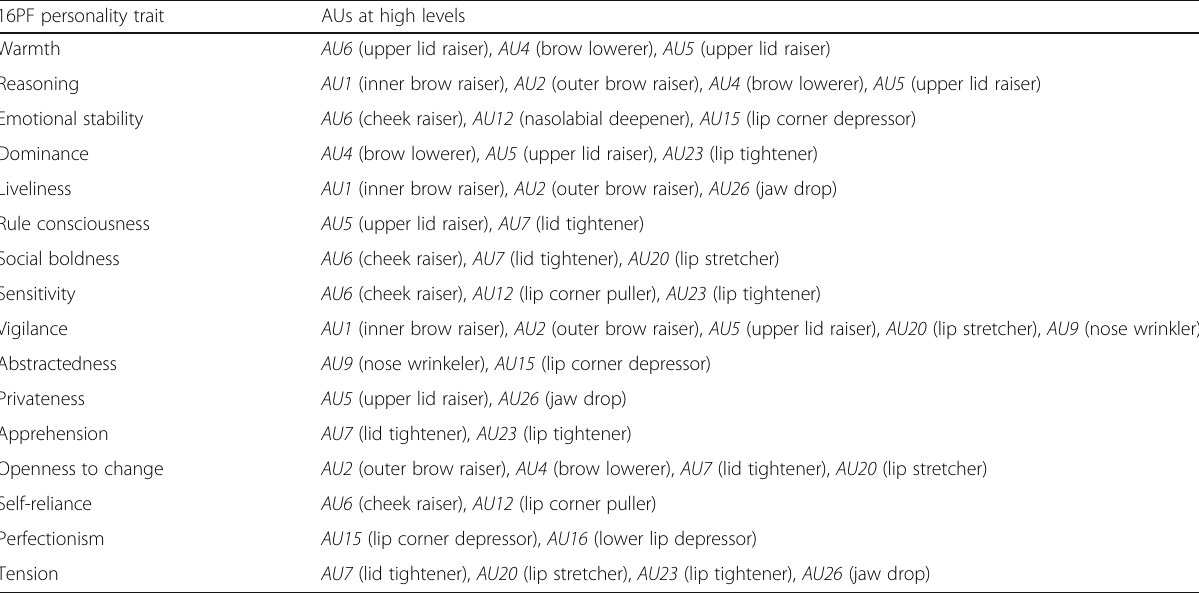
Table 6 Relationships between high-level AUs and high 16PF traits ’ prediction accuracy 16PF personality